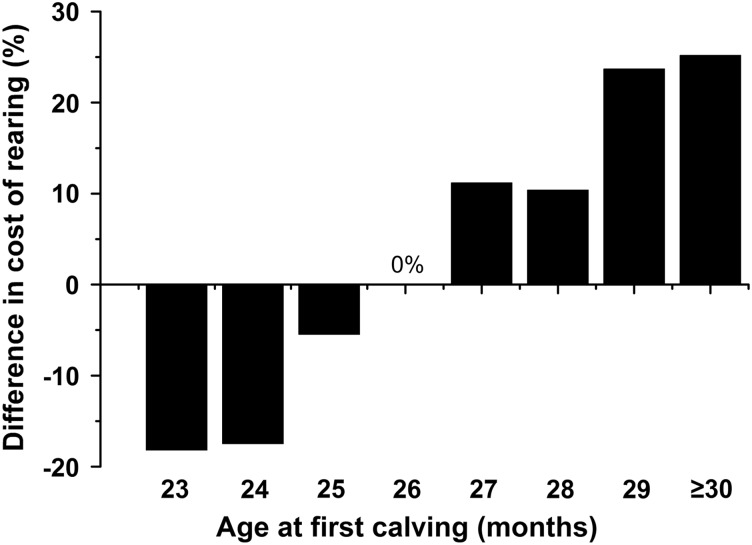
The estimated percentage difference in the total cost of rearing according to age at first calving, with 26 months taken as the base month (0%).